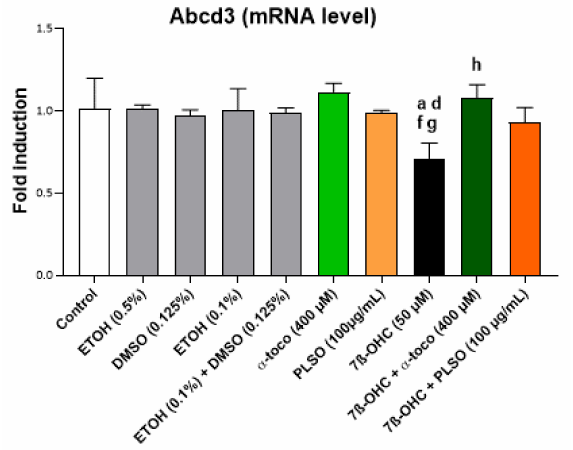
Figure 8. Effects of 7 β -hydroxycholesterol with and without Pistacia lentiscus L. on Abcd3 gene ex- pression. C2C12 cells were incubated for 24 h with or without 7 β -OHC (50 µ M) in the presence or absence of PLSO (100 µ g/mL) or α -tocopherol (400 µ M). The mRNA expression of Abcd3 was evaluated by qRT-PCR. Data shown are representative of three independent experiments. A multiple comparative analysis between the groups, taking into account the interactions, was carried out using an ANOVA test followed by a Tukey’s test. A p -value less than 0.05 was considered statistically significant. The statistically significant differences between the groups, which are indicated by different letters, take into account the ve- hicle used. a: comparison versus control; b: comparison versus ETOH (0.5%); c: comparison versus DMSO (0.125%); d: comparison versus ETOH (0.1%); e: comparison versus (ETOH (0.1%) + DMSO (0.125%)); f: comparison versus α -toco (400 µ M); g: comparison versus PLSO (100 µ g/mL); h: comparison versus 7 β -OHC (50 µ M); i: comparison versus 7 β -OHC (50 µ M) + α -toco (400 µ M). No significant differences were observed between the untreated (control) and vehicle-treated